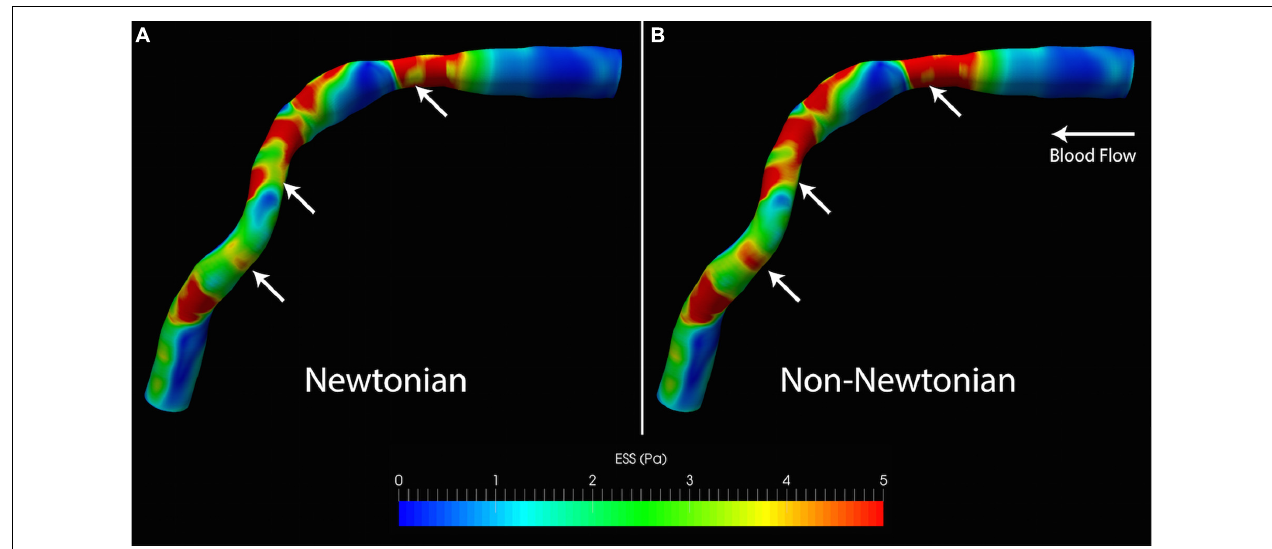
FIGURE 3 | Qualitative differences in ESS from (A) Newtonian and (B) non-Newtonian models. Although the distribution of high and low ESS is similar, the non-Newtonian model predicts higher ESS throughout the artery. This is visually most apparent from the larger areas exposed to high ESS (white arrows). ESS, endothelial shear